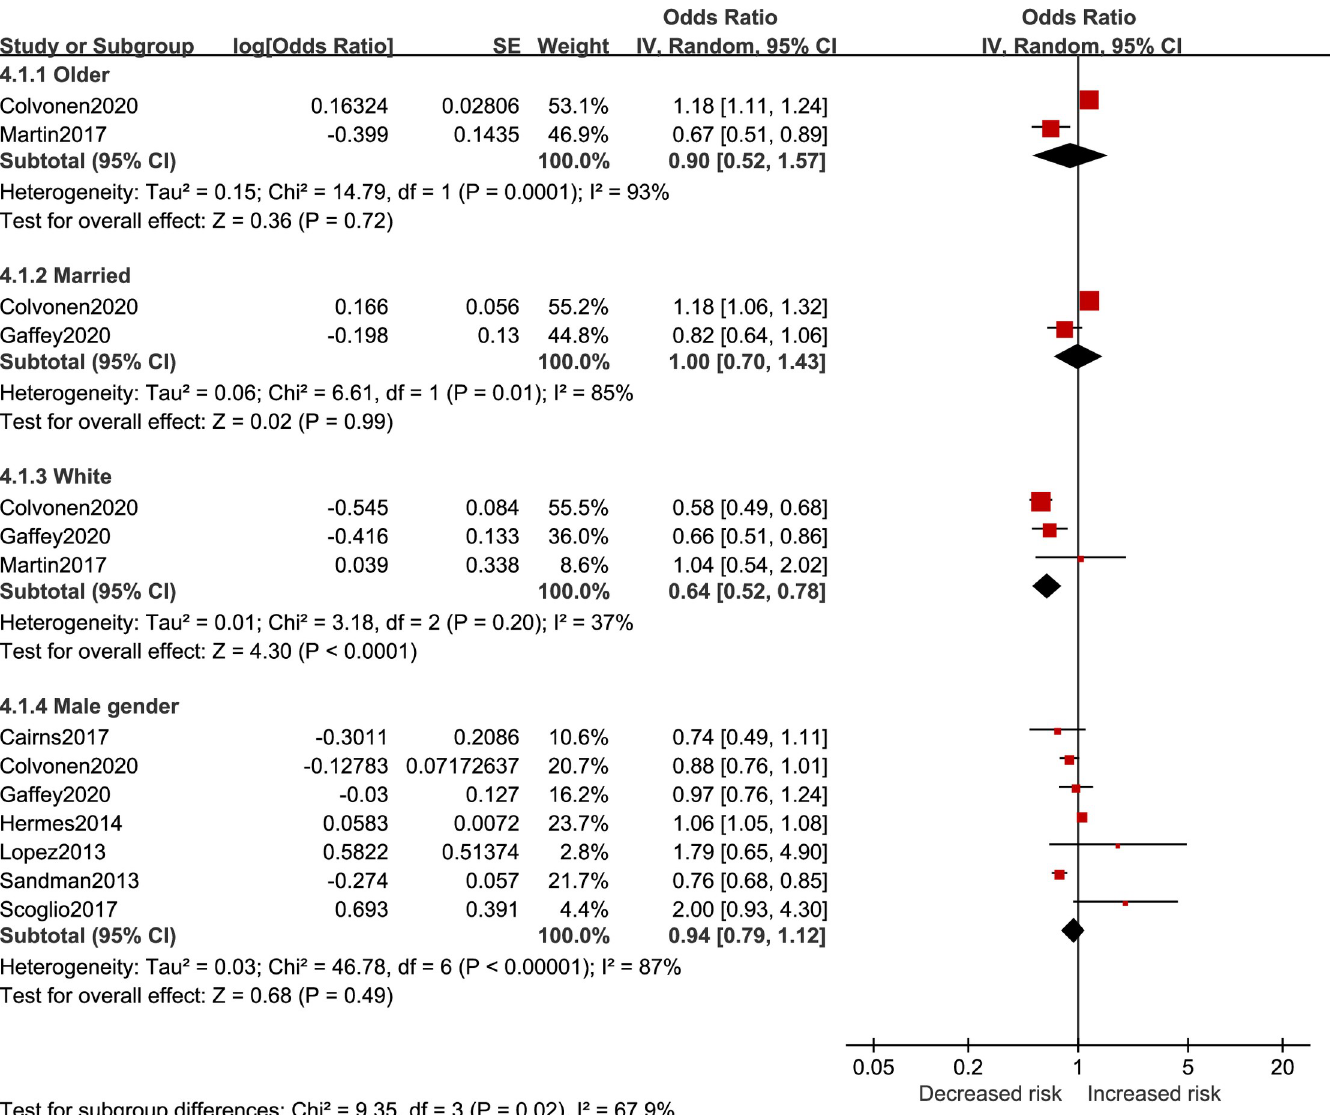
Fig 8. Sociodemographic factors for insomnia in